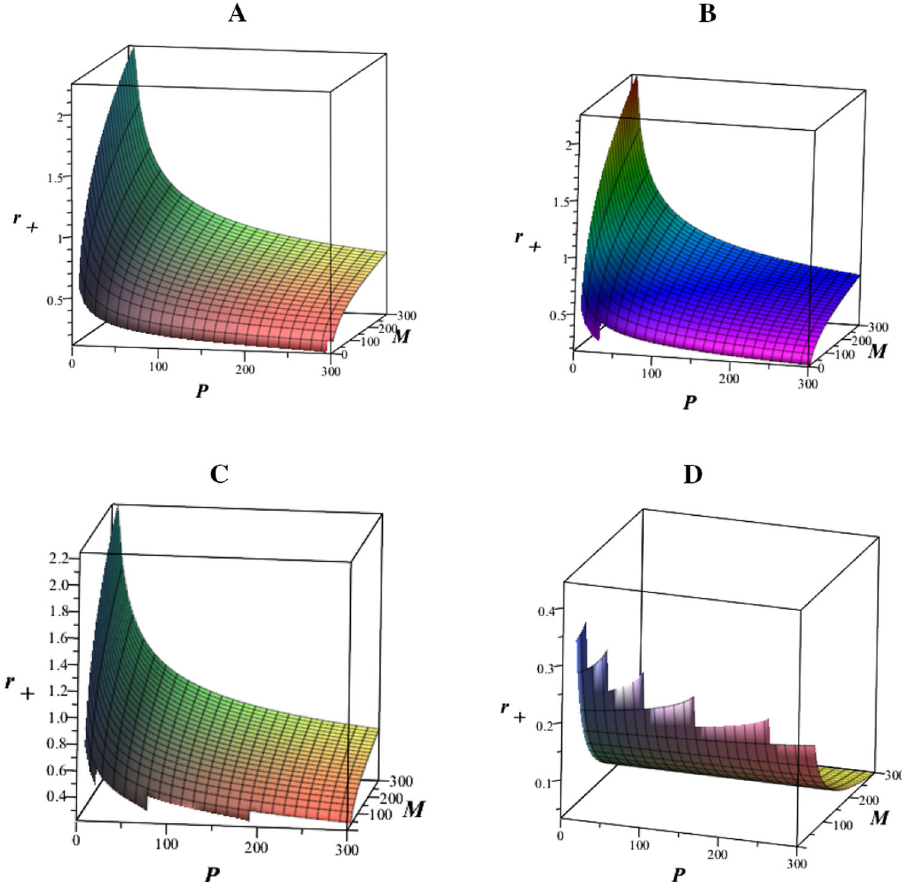
Fig. 7 Event horizon of dynamic phantom AdS BH for a 2 = 1. A : e 2 = 0 .